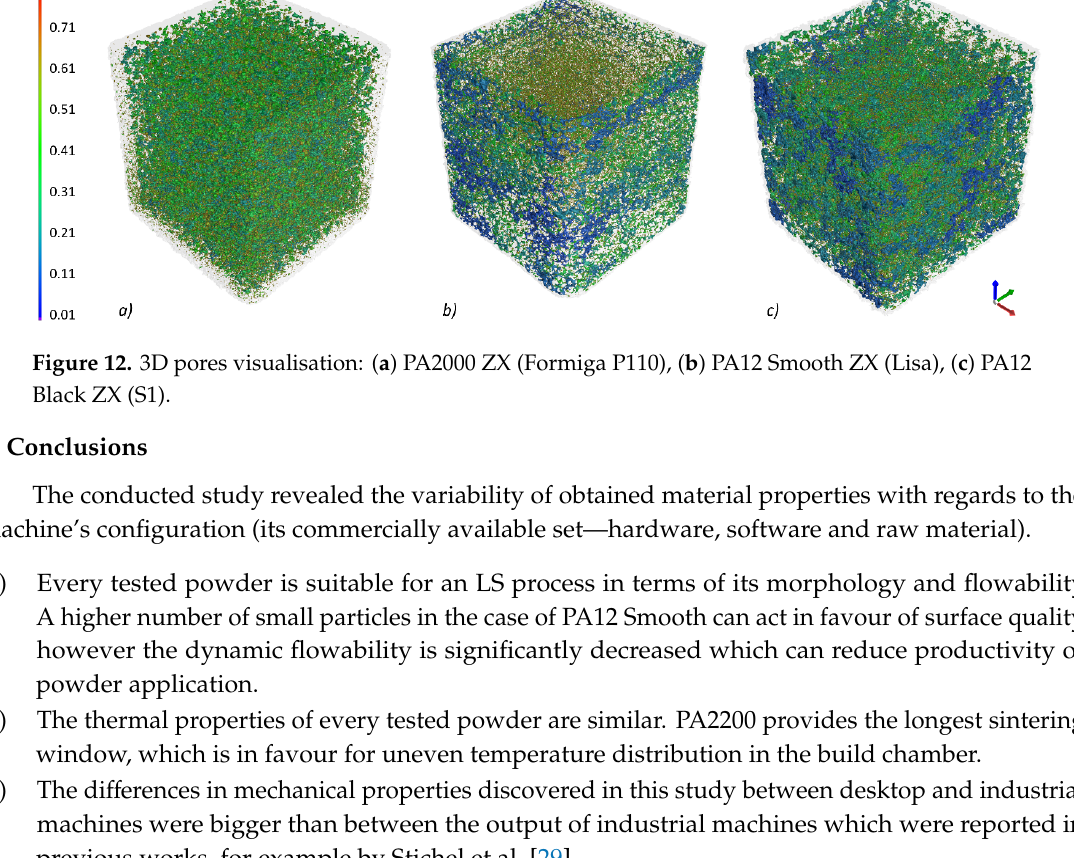
Figure 11. Porosity analysis: ( a ) dependency of sphericity and pore diameter related to the different building strategy, ( b ) XY, ( c ) XZ, ( d ) ZX.